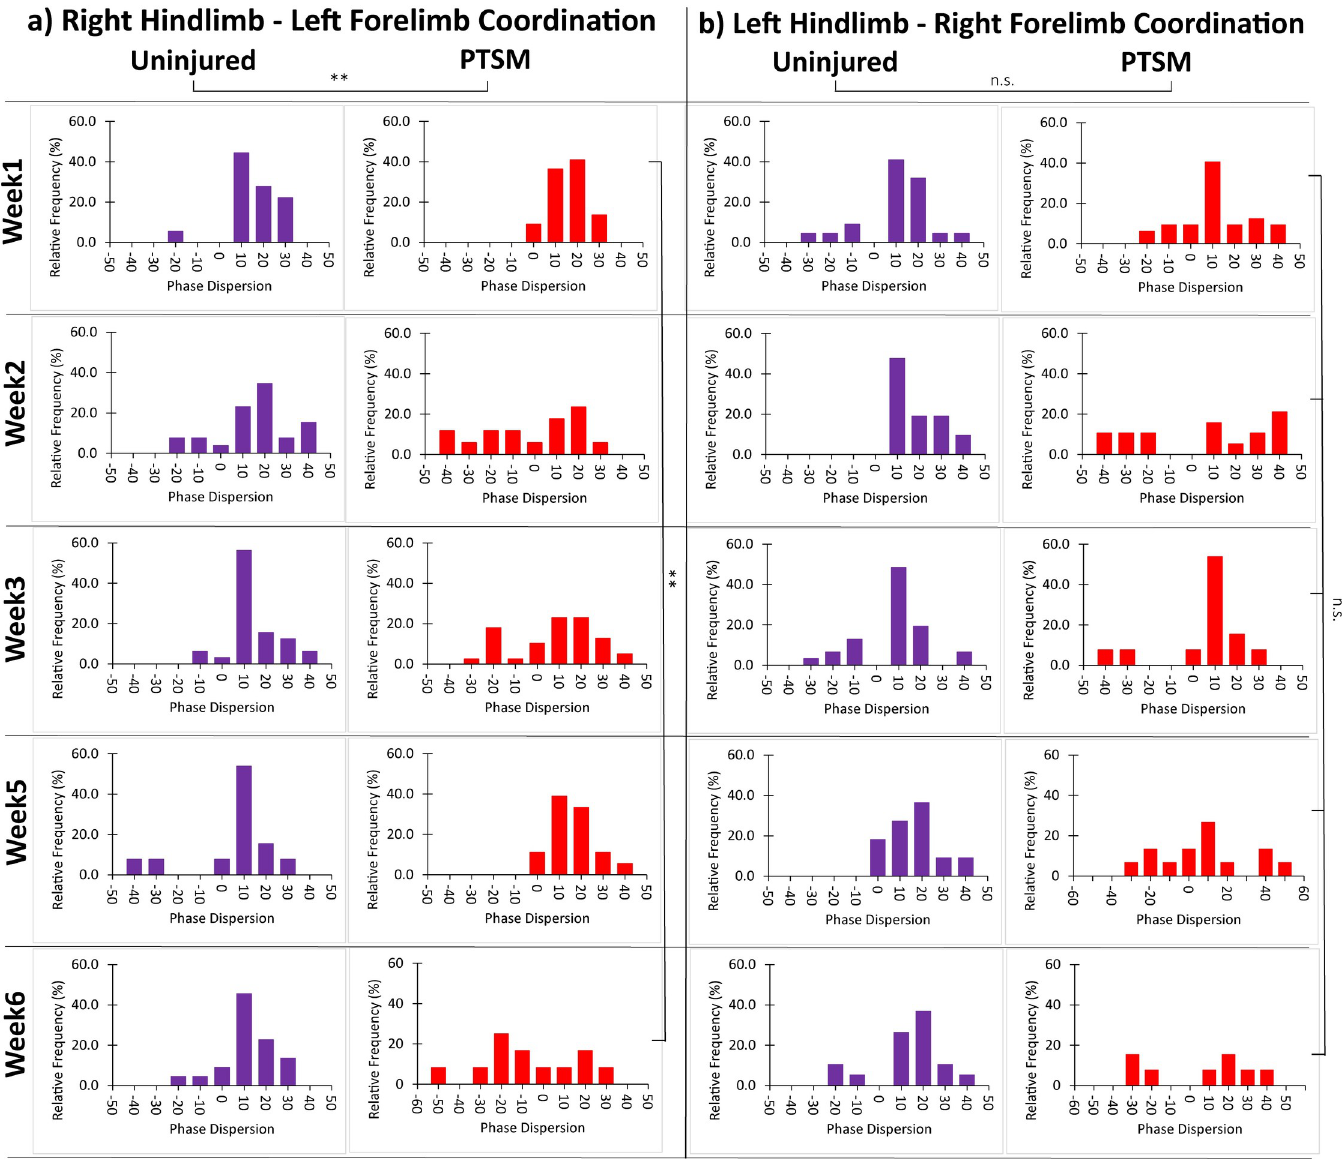
Fig 6. PTSM injury affects diagonal limb coordination of right hindlimb–left forelimb but not left hindlimb–right forelimb. a) The right hindlimb–left forelimb coordination was altered by PTSM injury with wide phase dispersion observed especially at week 6 as compared to week 1. b) There was no effect of PTSM injury on left hindlimb–right forelimb coordination. For all graphs, data are presented as histograms normalized to total step count at that particular time point. For the uninjured group n = 4–6 and PTSM group n = 6–9, and both groups subsamples (steps) s = 4 to 6. � denotes p < 0.05, �� denotes p < 0.01, ��� denotes p < 0.005, ���� denotes p < 0.001 represents statistical significance as determined by the mixed-effect model with Tukey’s post hoc ( p <